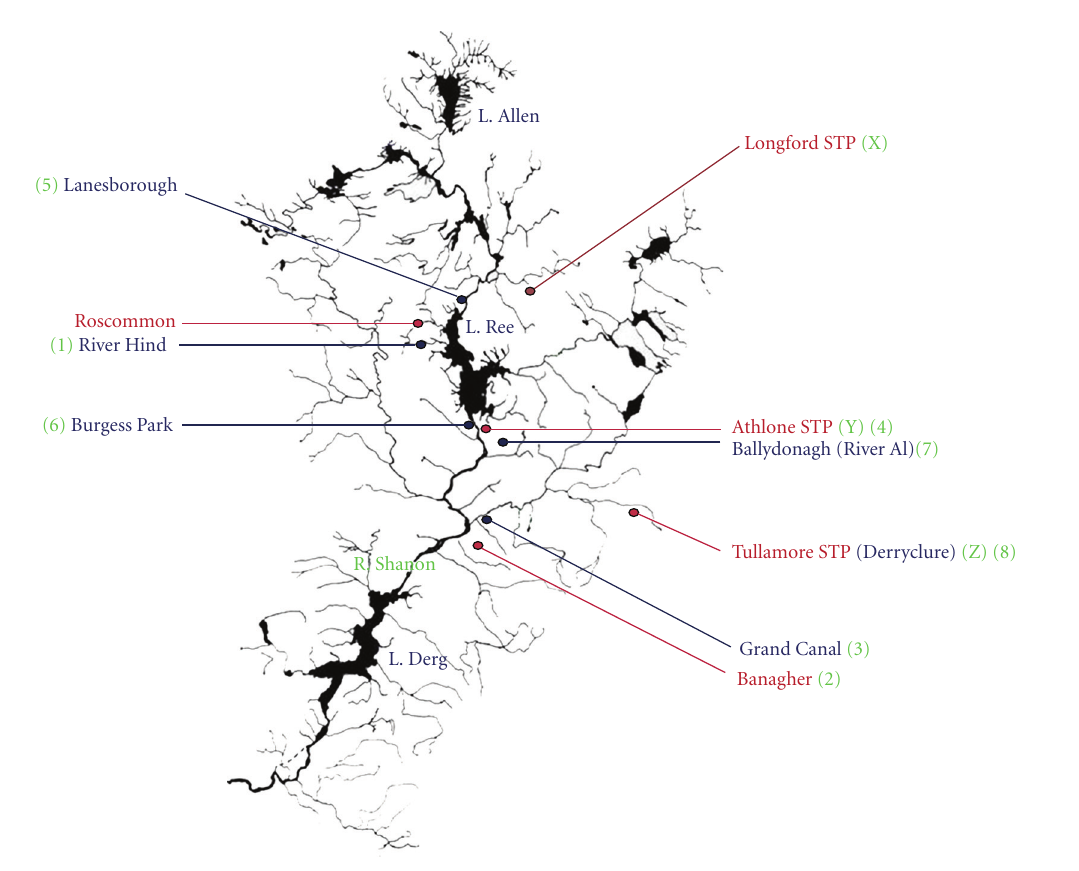
Figure 2: The Shannon Catchment test